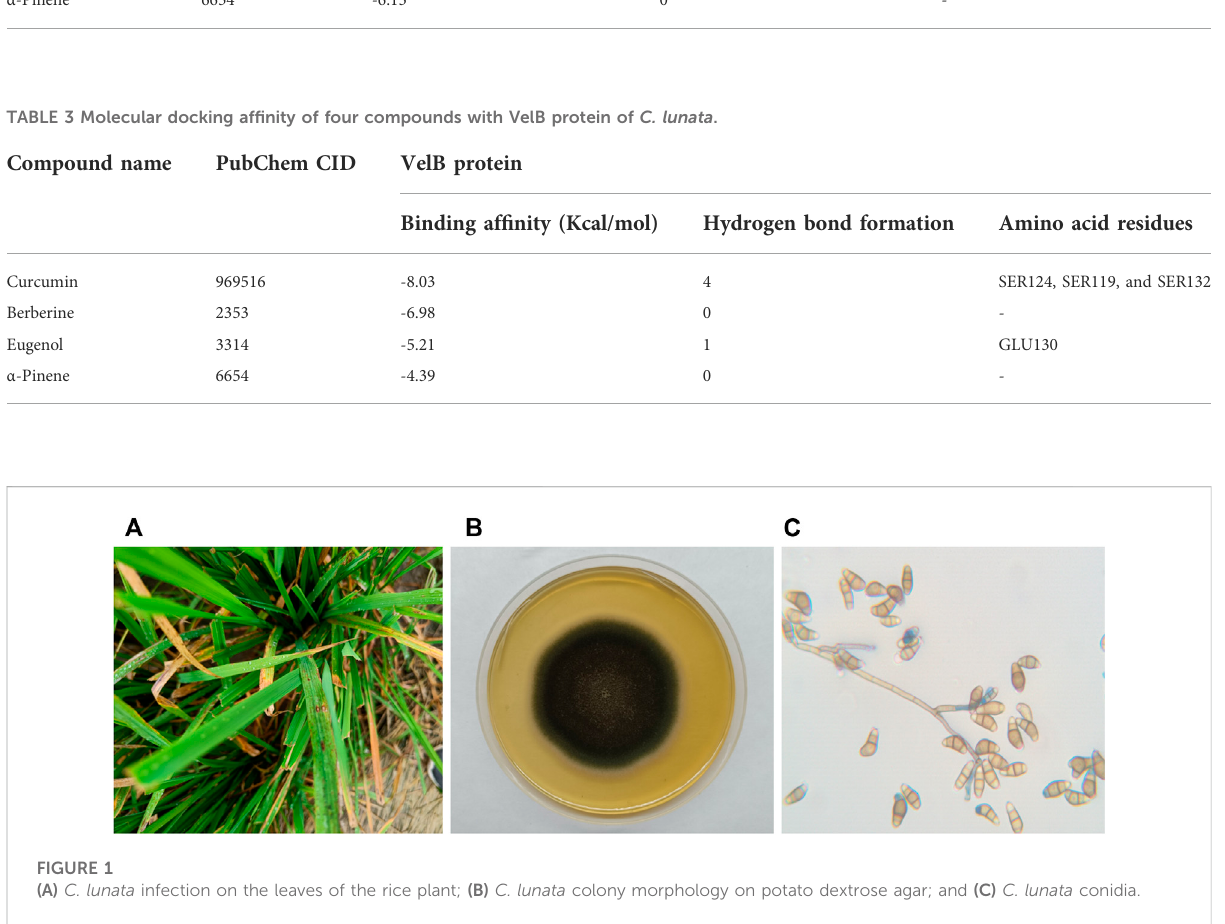
(Figure 1). The fungal isolate was identi fi ed as Curvularia based on its colony morphology, viz., fl uffy and velvety mycelia, greyish black colour, black pigment on the reverse side, and straight to pyriform conidia having three to four cells, with a large and curved central cell with smooth-walled in a lactophenol cotton blue mount. Morphological characteristics of the isolated fungus were in agreement with Ellis (1971) and Sivanesan (1984).